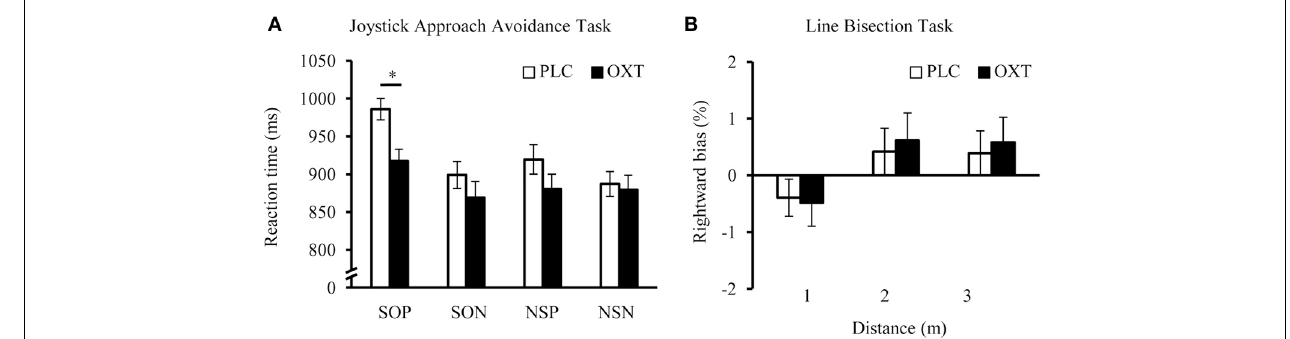
FIGURE 2 | Effects of OXT in the Joystick Approach-Avoidance (A) and Line Bisection Task (B). OXT specifically accelerated the approach toward social positive stimuli, but did not influence motor responses to negative or non-social cues. In the Line Bisection Task a right pseudo-neglect occurred if the line was presented in a near distance and this bias shifted leftward at